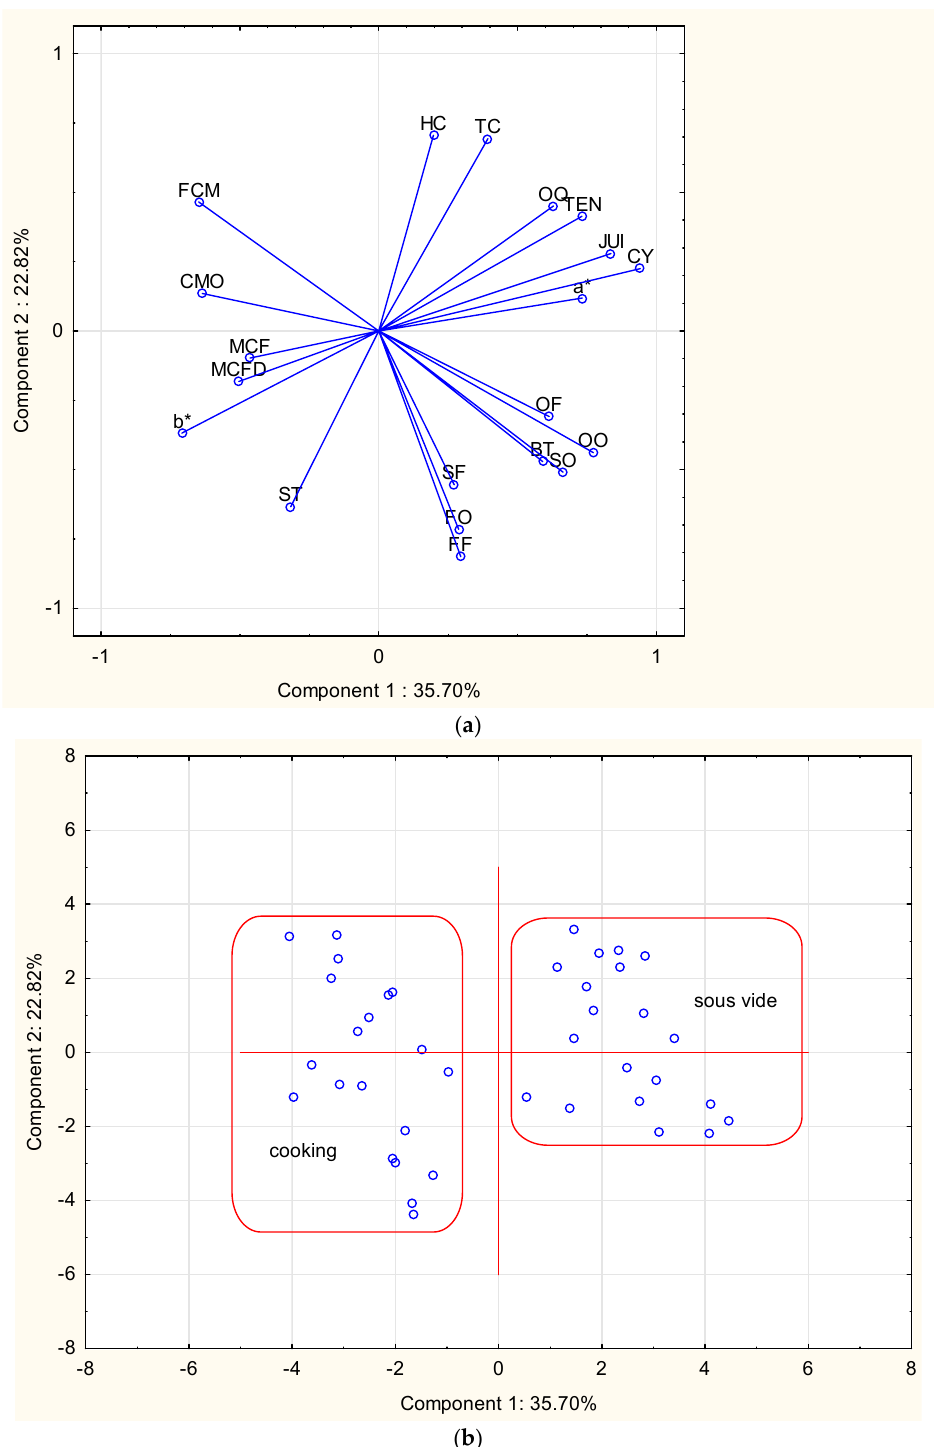
Figure 2. Results of principal component analysis (PCA). ( a ) projection of variables on the plane of PC; HC: homogeneity of color; TC: tone of color; OQ: overall quality; TEN: tenderness; JUI: juiciness; CY: cooking yield; a*:redness of meat: OF: other flavor; OO: other odor; BT: bitter taste; SO: sour odor; SF: sour flavor; FO: fatty odor; FF: fatty flavor; ST: salty taste; b*: yellowness of meat; MCFD: maximum cutting force depth; MCF: maximum cutting force; CMO: cooked meat odor; FCM: flavor of cooked meat; ( b ) projection of cases on the plane of PC; Samples from individual methods are included in the indicated areas.